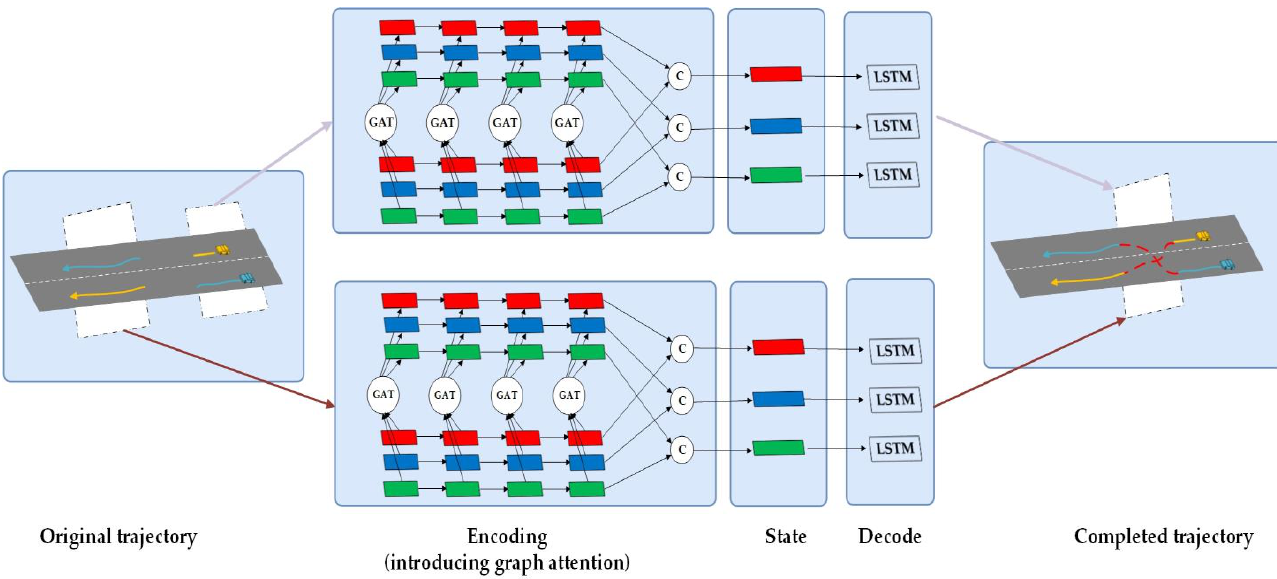
Figure 5. The neural network structure of the bidirectional LSTM vehicle trajectory completion model based on graph attention.